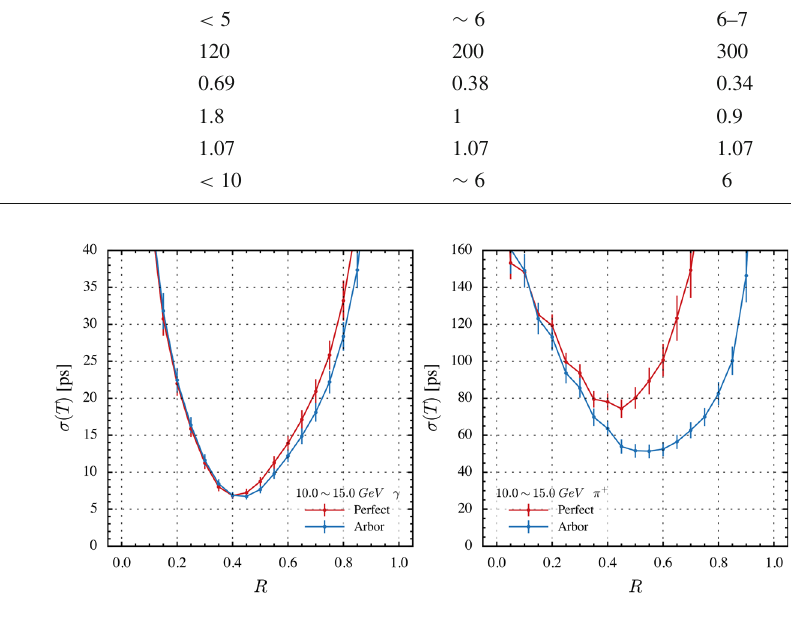
Fig. 16 The shower time resolution for the Arbor clusters (left) and the time resolution ratio of perfect clusters over Arbor clusters (right) as a function of incident